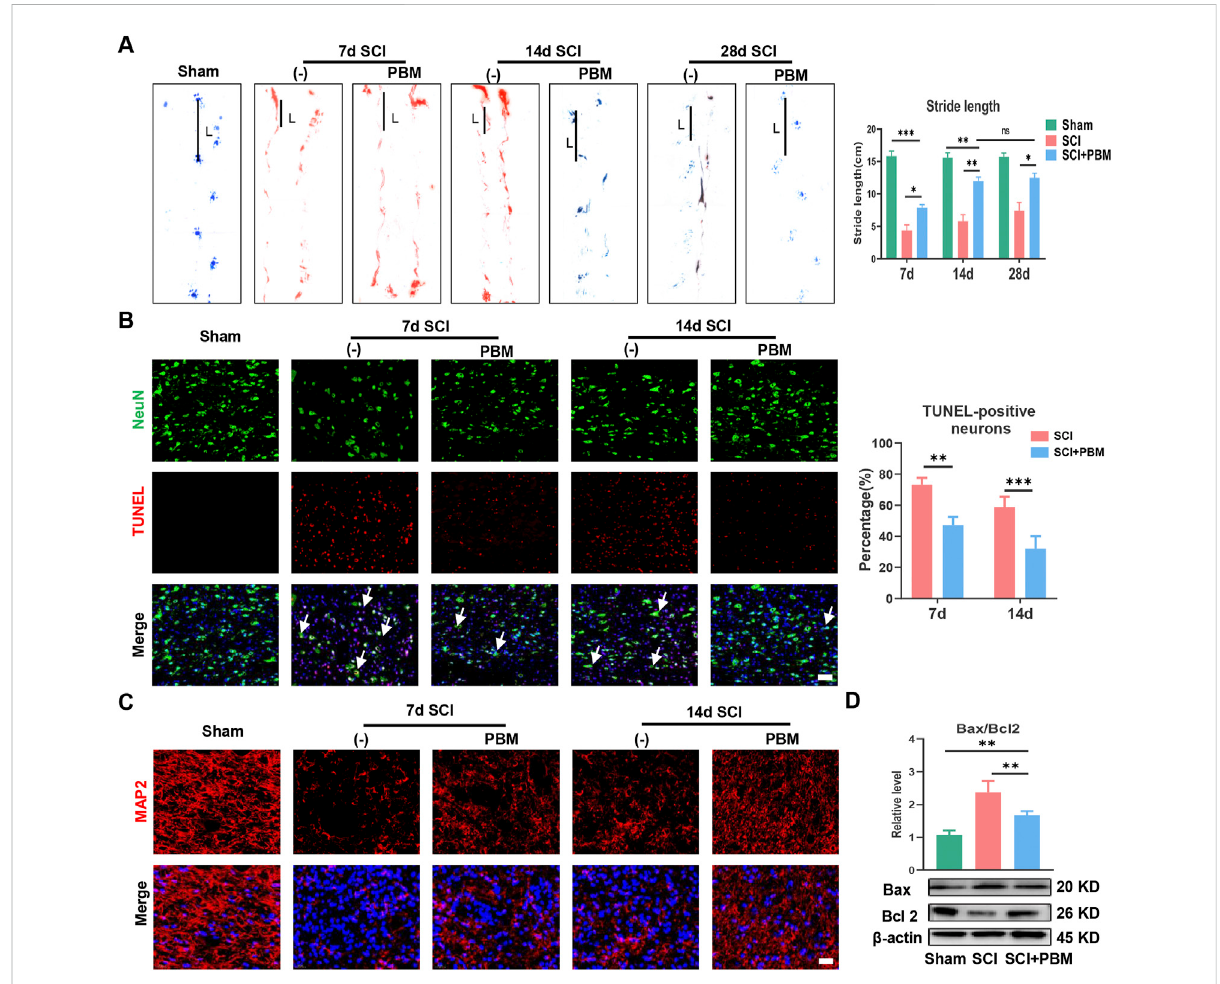
FIGURE 1 PBM promoted motor function recovery and alleviated mitochondrial-related neuronal apoptosis. (A) : Representative gaits of each group at 7, 14,and28 dpi.Thestridelengthwascalculated, n =3. (B) :TUNEL(red)andNeuN(green)co-stainedandthearrowspointtorepresentativecells.The ratio of TUNLE-positive neurons was calculated, Scale bar: 50 µm, n = 3. (C) : Neurons was stained with MAP2, and nuclei were stained with DAPI (blue), Scale bar: 50 µm. (D) : Western blot analysis and quanti fi cation of Bax/Bcl2 levels in each group, n =